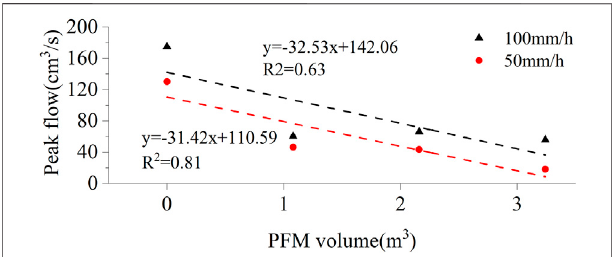
FIGURE 7 | Variation of the peak fl ow in different PFM volumes under 100 mm h − 1 and 50 mm h − 1 rainfall